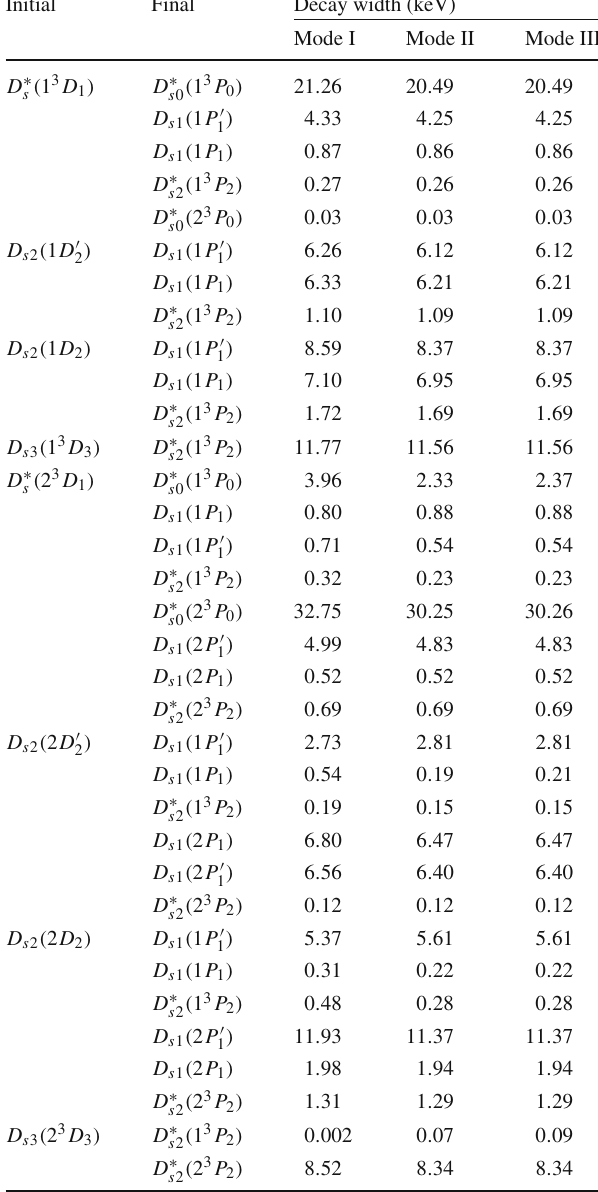
Table 6 The same as Table 5 but for D → P γ process Initial Final Decay width (keV) are estimated to be 285 . 3 and 86 . 25 MeV, Mode I Mode II